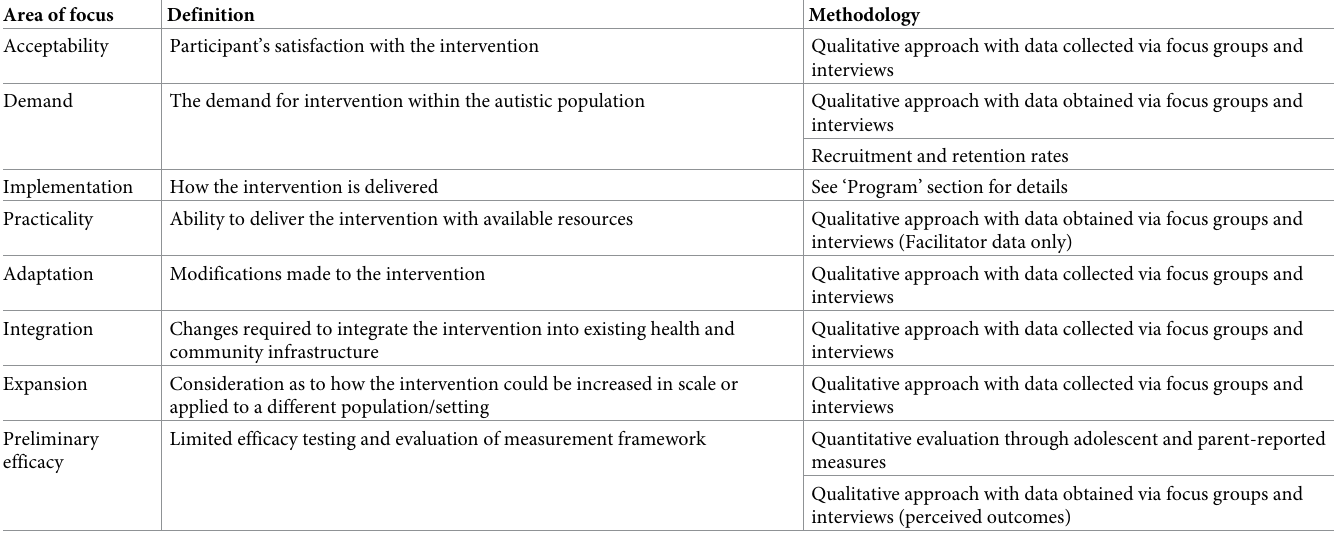
Table 1. Methods to investigate feasibility based on Bowen et al.